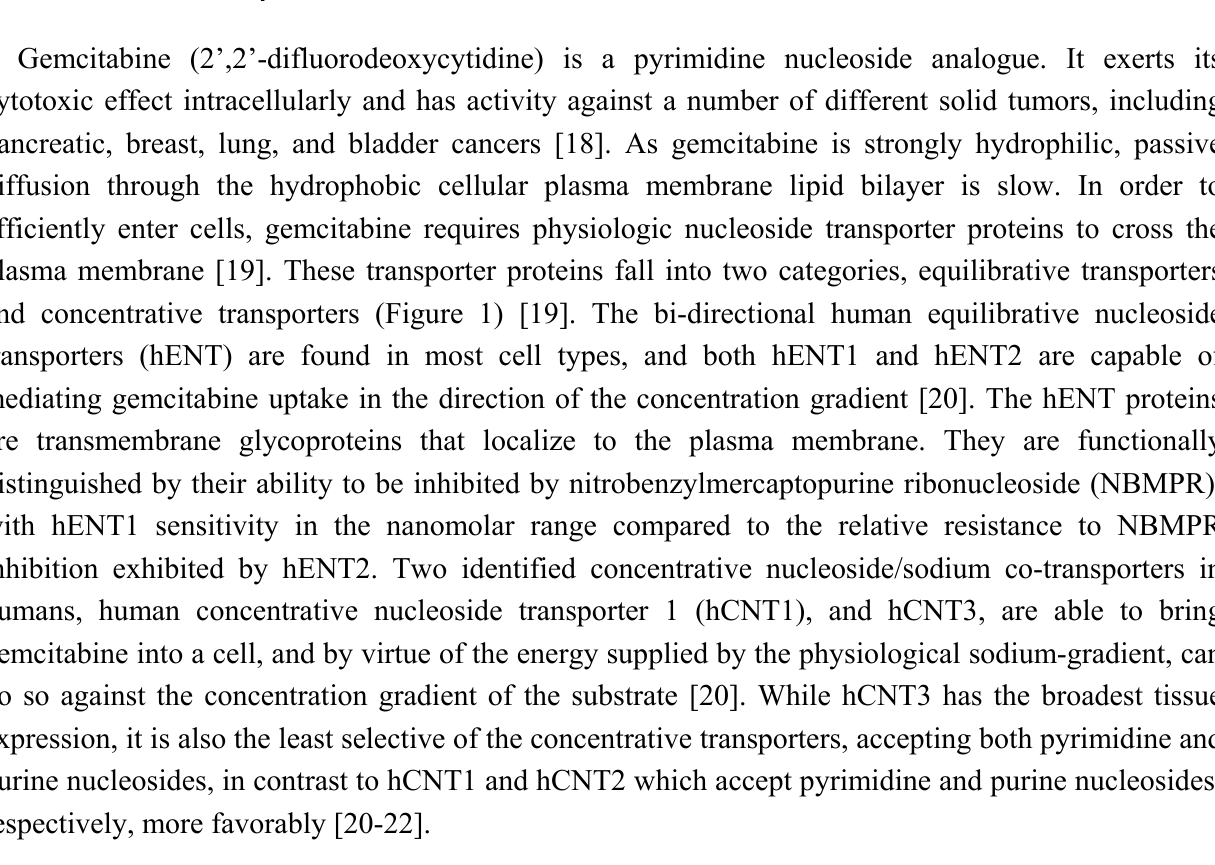
Figure 1. Gemcitabine transport. Abbreviations: Na + , sodium; hCNT, human concentrative nucleoside transporter; hENT, human equilibrative nucleoside